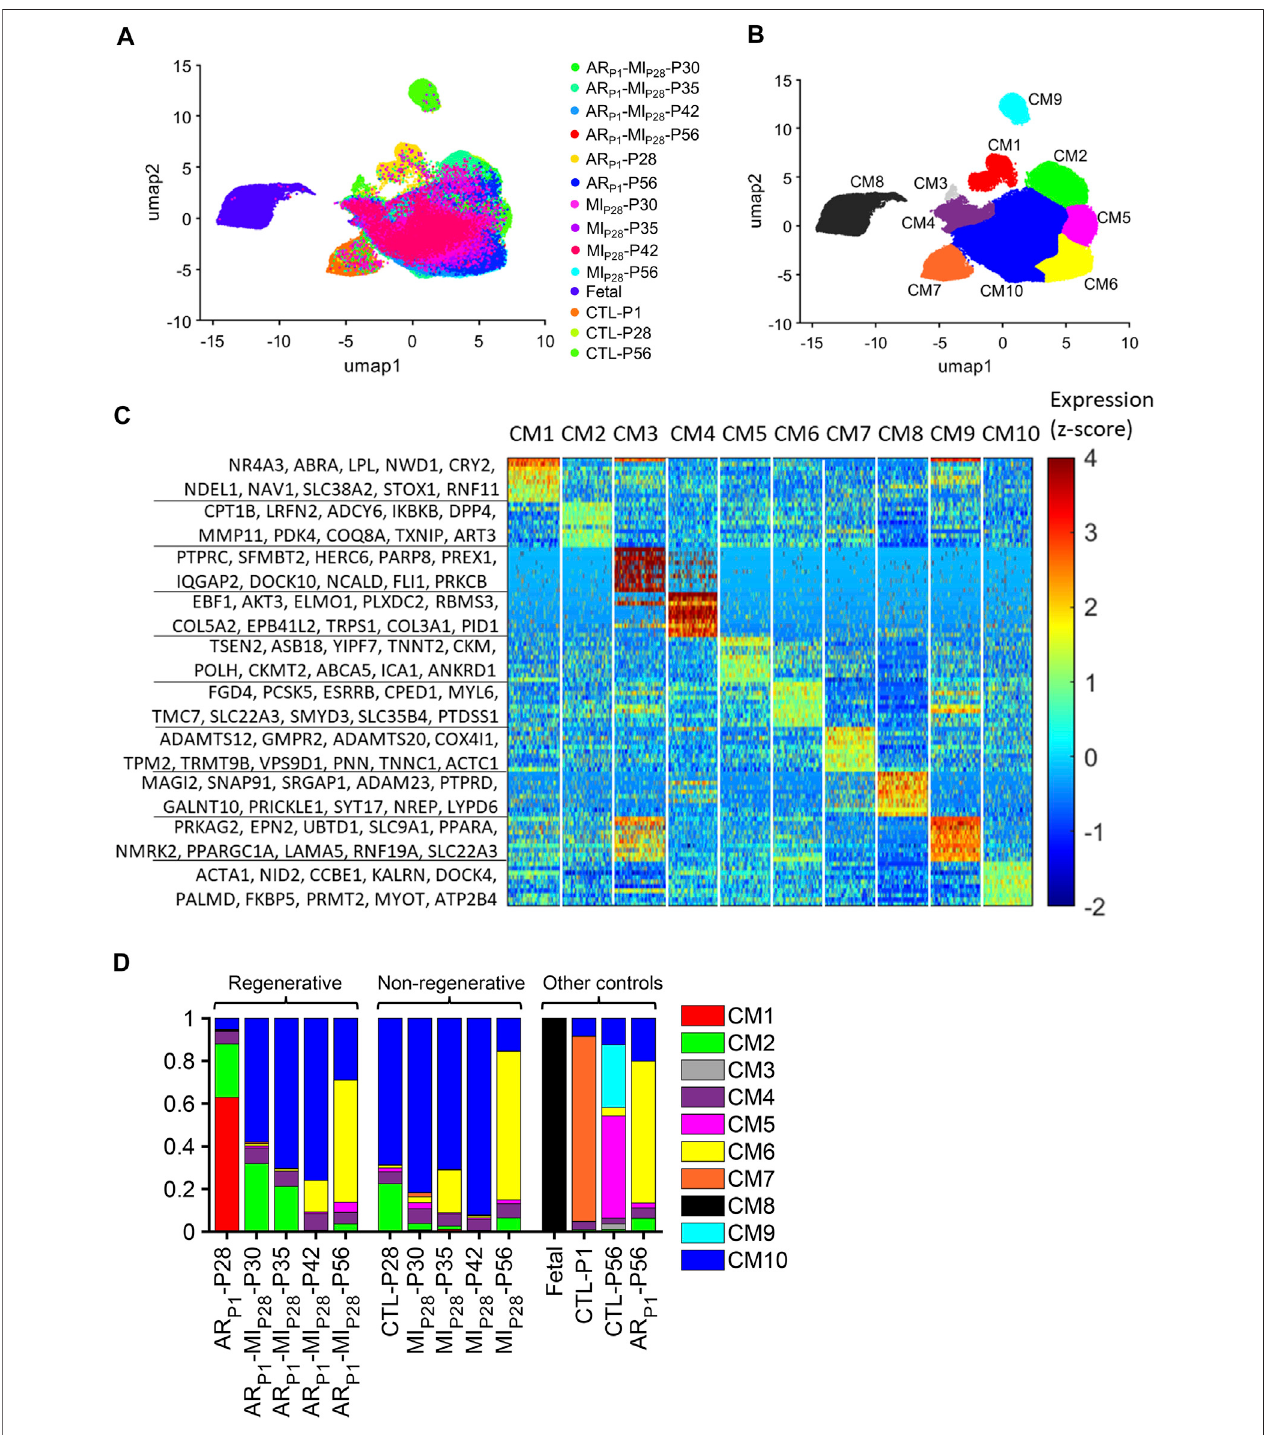
FIGURE 1 | Cluster analysis identi fi ed 10 populations of cardiomyocytes in Fetal, CTL, AR P1 , MI P28 , and AR P1 MI P28 hearts. (A,B) Cardiomyocyte snRNA-seq data were reduced to 10 dimensions with an autoencoder, processed via cluster analysis, visualized via UMAP, and displayed according to (A) experimental group and time point and (B) cluster (CM1 – CM10). (C) The expression of genes that were explicitly associated with each cluster is displayed as a heat map. (D) The proportion of cardiomyocytes from each cluster is displayed for each experimental group and time point.